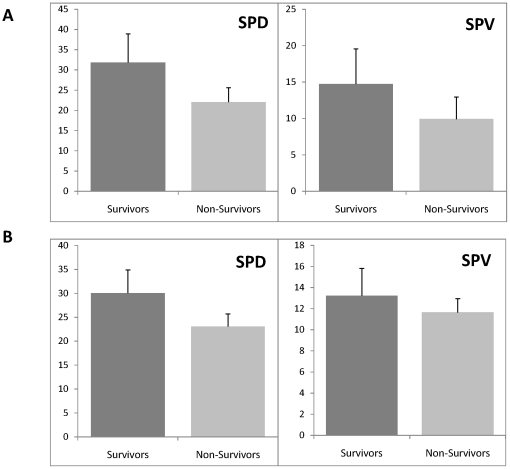
Index of SP diversity (SPD) and Index of SP variability (SPV) for Survivors and Non-Survivors.(A) Complete groups (medicated + unmedicated) of patients. Data averaged across 171 (for Survivors) and 53 (for Non-Survivors) one-minute EEG signals and across 19 EEG channels and presented as mean ± standard deviation. (B) Sub-groups of unmedicated patients only. Data averaged across 124 (for Survivors) and 33 (for Non-Survivors) one-minute EEG signals and across 19 EEG channels and presented as mean ± standard deviation. SP – spectral pattern; Survivors – patients who survived 6 months after brain injury; Non-Survivors – patients who died 6 months after brain injury.